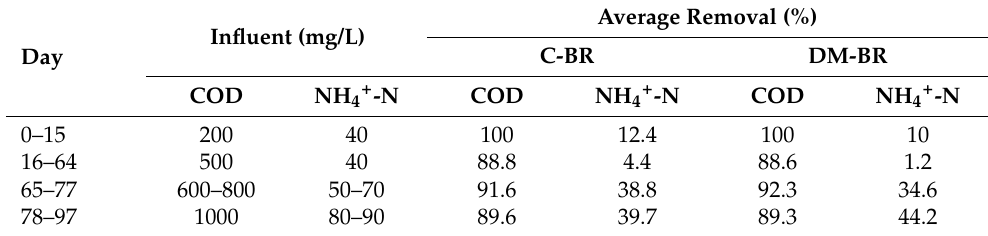
Table 2. Removal of COD and NH 4+ -N in DM-BR and C-BR throughout acclimatisation.